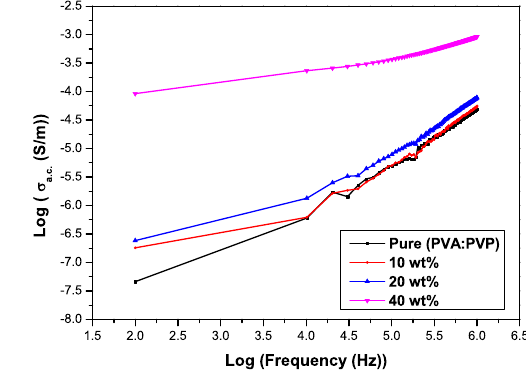
Figure 4: Log-log plot of A.C. electrical conductivity as a function of the frequency of pure and PVA:PVP poly- mer blend films reinforced with different weight ratios of CdCl 2 · H 2 O